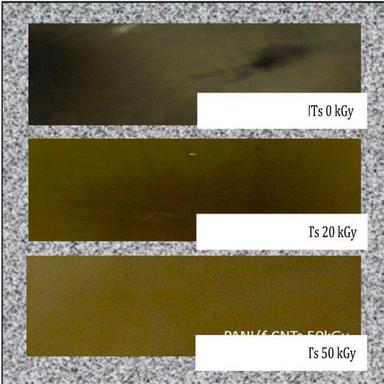
The images of PVA/PANI/functionalized CNT nanocomposite film irradiated at 0 kGy, 20 kGy and 50 kGy by gamma irradiation. (For interpretation of the references to colour in this figure, the reader is referred to the web version of this article.)